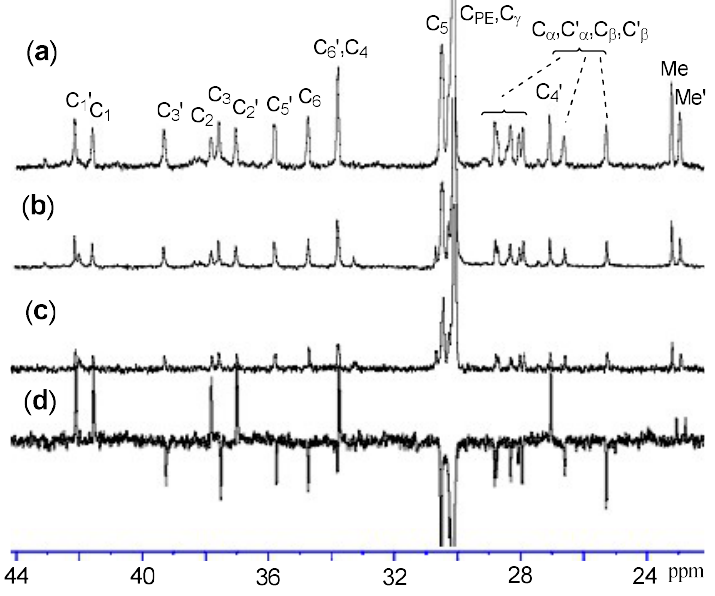
Figure 9 . 13 C NMR spectra ( a – c ) and ( d ) the DEPT spectrum for poly(E- co -4-MeCHE)s prepared by ( 8 ) [34].